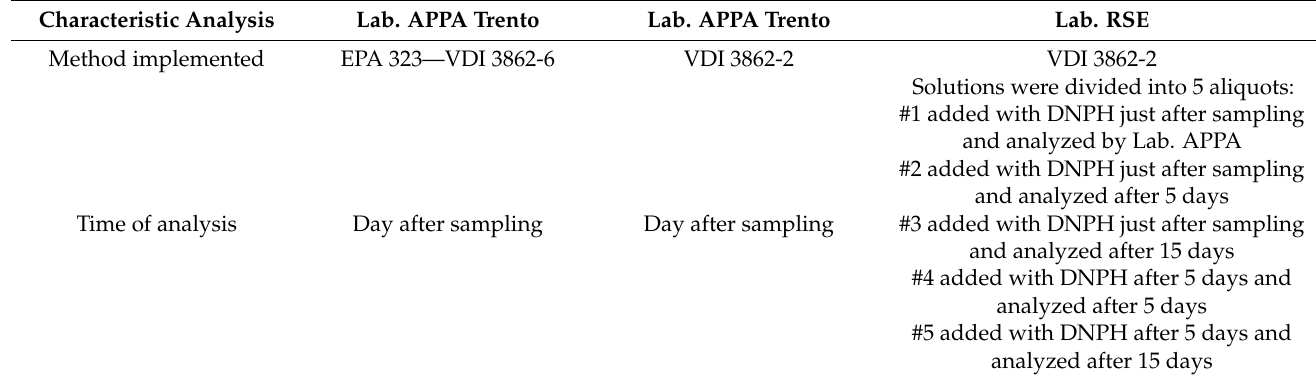
Table 5. Description of samples during the Second Campaign.